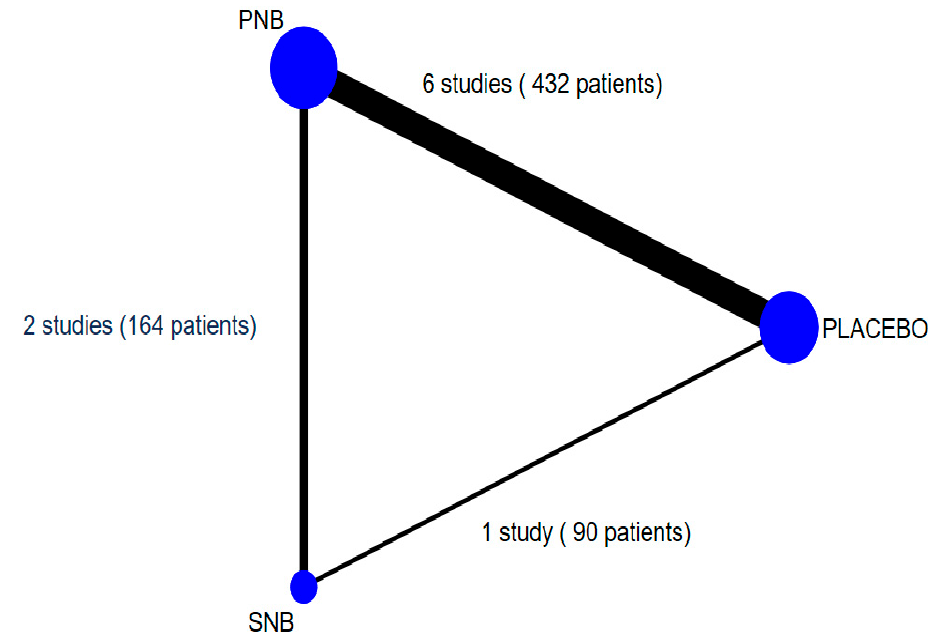
Figure 4. Network map of included studies for the incidence of ISP. Width of the lines is the number of trials comparing pairwise intervention. Size of the circles is proportion of the sample. ISP, ipsilateral shoulder pain. Table 2. Comparisons of interventions for reduction in incidence of ISP during the first 24 h after surgery in network meta-analysis.